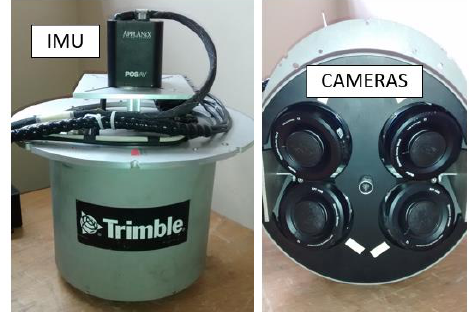
Figure 2. The TACx4 system. (Ercolin Filho et al.,